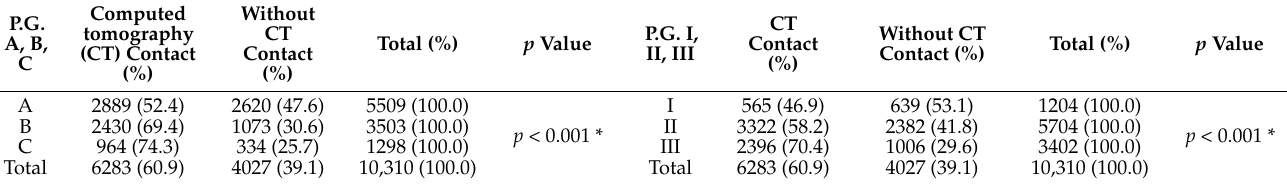
Table 5. Association between the Pell and Gregory classification and contact in cone beam computed tomography (CBCT). P.G. A, B,